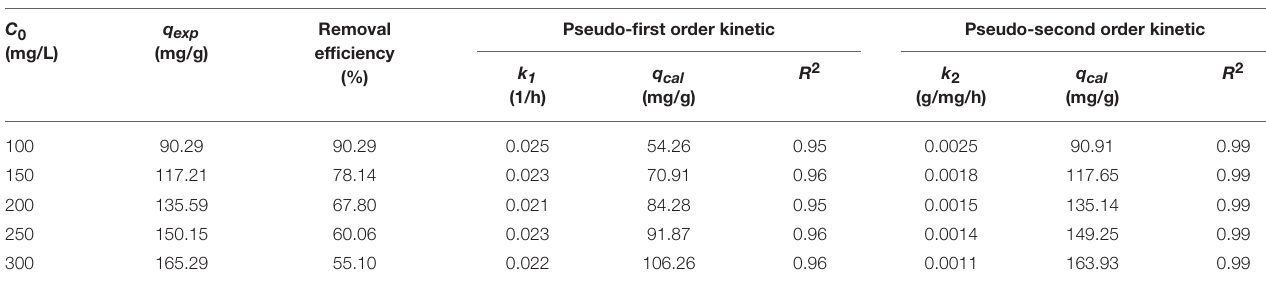
TABLE 1 | Kinetic parameters of iodine adsorption over JLUE-COP-3. C 0 q exp Removal (mg/L) (mg/g) efficiency (%)